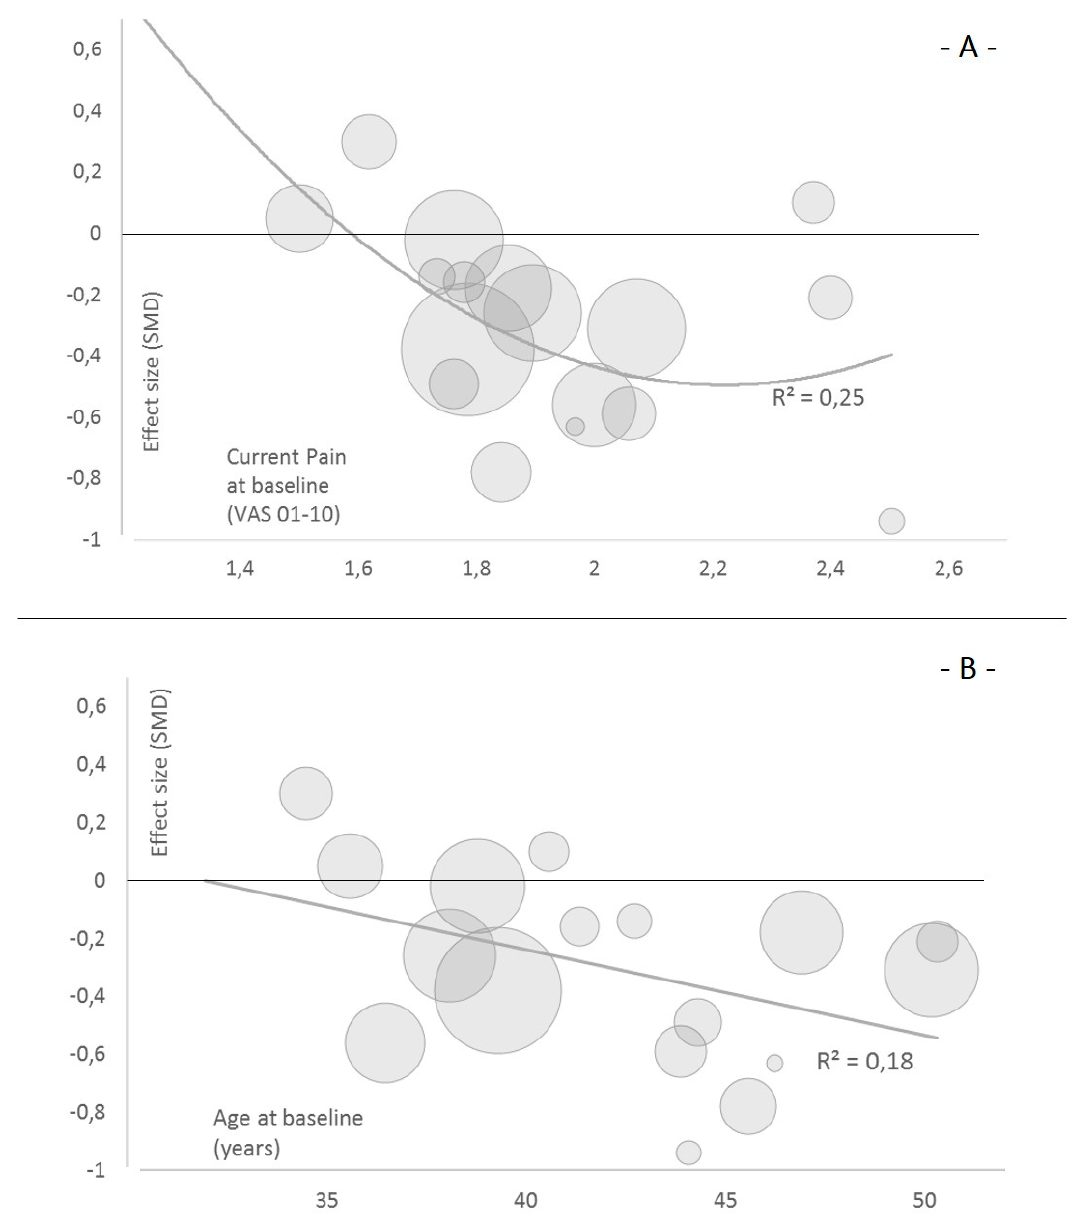
Figure 5. Bubble plots of the meta-regressions (single predictor). ( A ) current pain intensity at baseline and ( B ) participants mean age at baseline on the effect size estimator of the mid-term effect (12 weeks) on disability. The size of the bubble illustrates the weighting of the respective study arm by inverse variance.